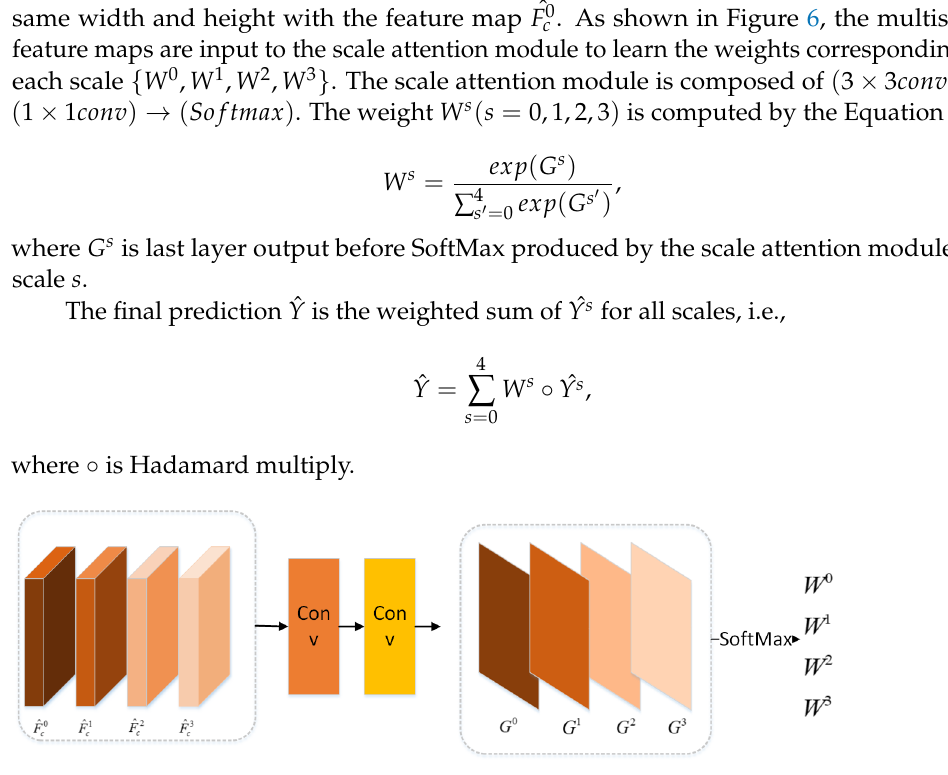
Figure 6. Scale Attention